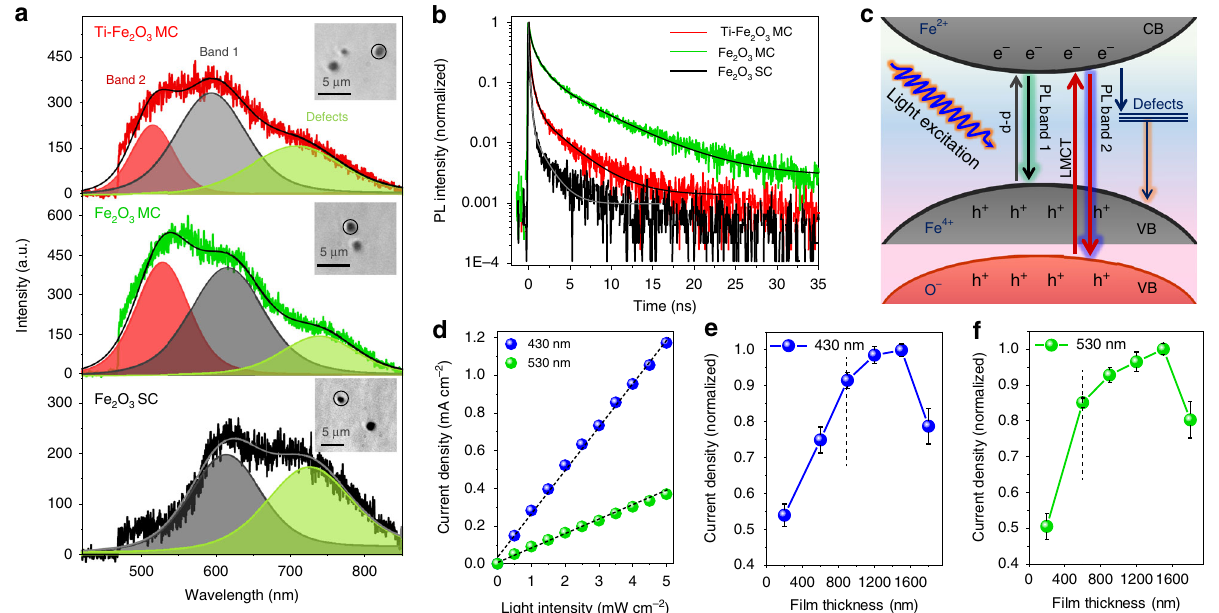
Fig. 6 Time-resolved PL measurements and wavelength-dependent current generation. a Emission spectrum (Inset shows the corresponding optical transmission images) and b decay pro fi les collected from isolated small aggregates of Ti – Fe 2 O 3 MCs, Fe 2 O 3 MCs, and Fe 2 O 3 SCs. c The proposed electronic transitions and charge recombination process in MC. d Current density at 1.23 V vs. RHE of the Ti – Fe 2 O 3 MC photoanode under monochromatic light illumination (430 nm and 530 nm) from the back side. The normalized current density at 1.23 V vs. RHE of the Ti-Fe 2 O 3 MC photoanodes with different fi lm thicknesses under e 430-nm and f 530-nm monochromatic light illumination from the back